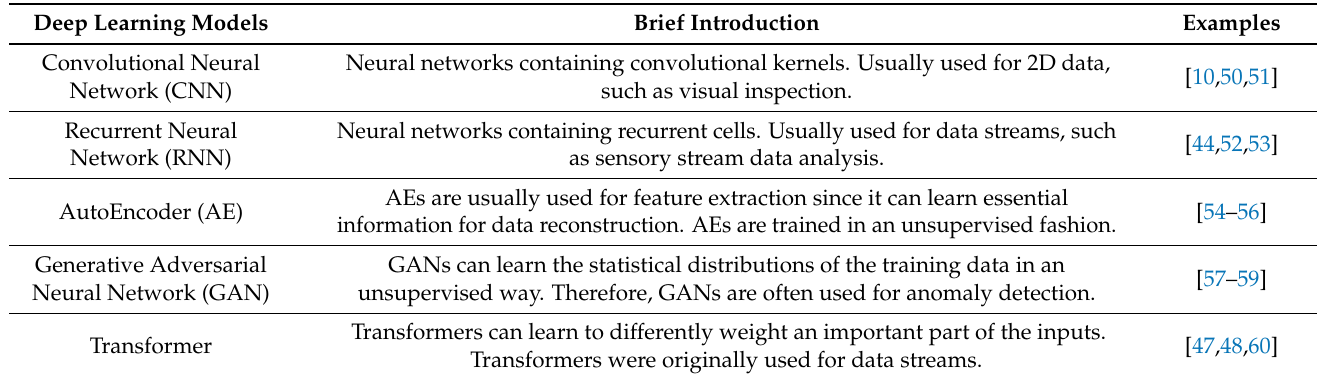
Table 2. List of commonly used deep learning models and the related use case examples in smart